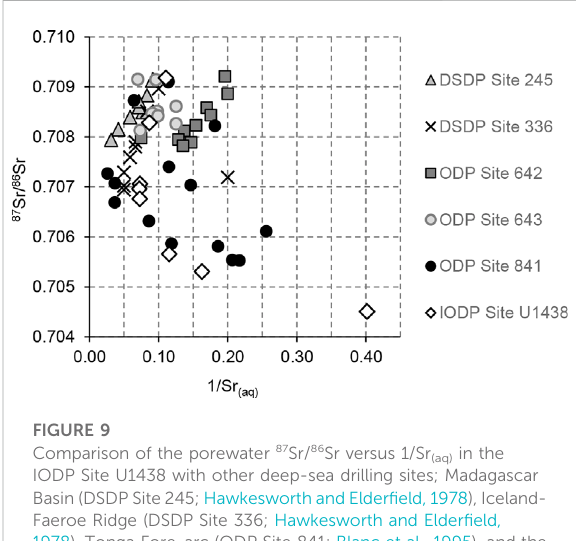
FIGURE 9 Comparison of the porewater 87 Sr/ 86 Sr versus 1/Sr (aq) in the IODP Site U1438 with other deep-sea drilling sites; Madagascar Basin (DSDP Site 245; Hawkesworth and Elder fi eld, 1978), Iceland- Faeroe Ridge (DSDP Site 336; Hawkesworth and Elder fi eld, 1978), Tonga Fore-arc (ODP Site 841; Blanc et al., 1995), and the Vøring Plateau (ODP Sites 642 and 643; Aagaard et al.,